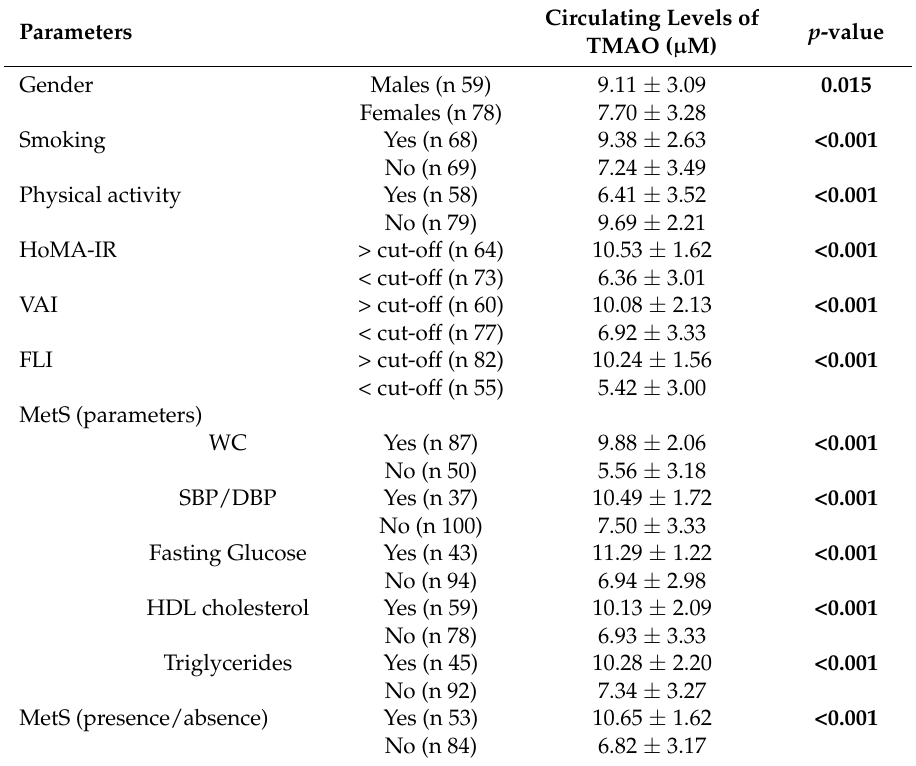
Table 2. Circulating levels of TMAO in the study population according to gender, lifestyle habits, cardio-metabolic indices, and